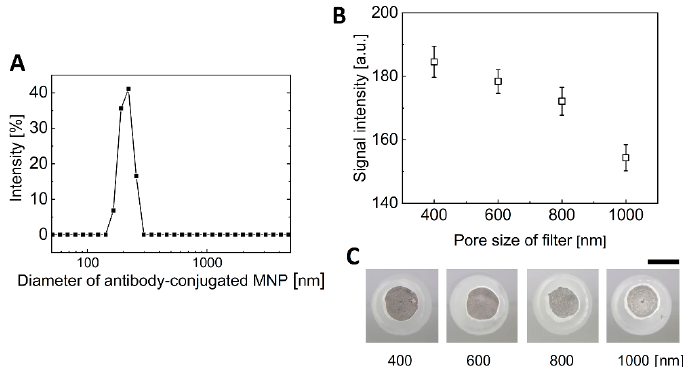
Figure 3. Effect of the pore size of the membrane filter on the negative control. (A) The size Figure 3. E ff ect of the pore size of the membrane filter on the negative control. ( A ) The size distribution distribution of antibody-conjugated MNPs. (B) The negative control signal of four membrane filters of antibody-conjugated MNPs. ( B ) The negative control signal of four membrane filters with di ff erent with different pore sizes. (C) Images of the membrane filter. Scale bar = 3 mm. pore sizes. ( C ) Images of the membrane filter. Scale bar = 3 mm.